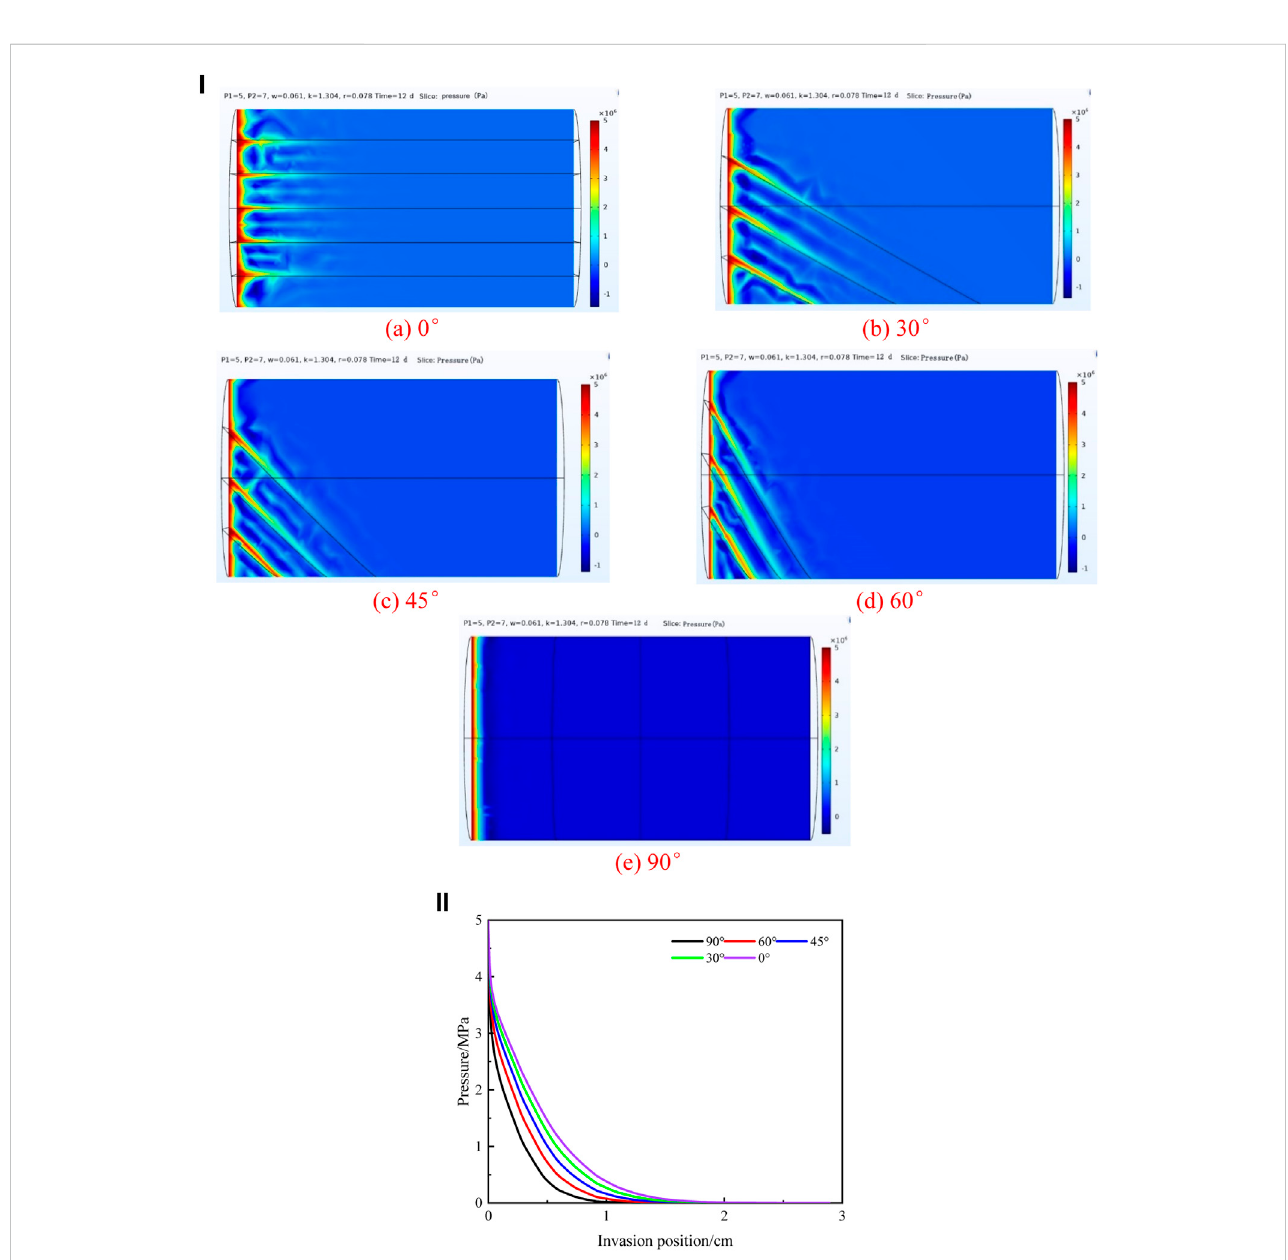
FIGURE 12 (i) : Cloud diagram of the invasion effect underdifferent angles to the bedding plane. (A) 0, (B) 30, (C) 45, (D) 60, and (E) 90. (ii) :Changes of fl uidpressure between bedding fractures with the invasion position under different angles to the bedding plane.